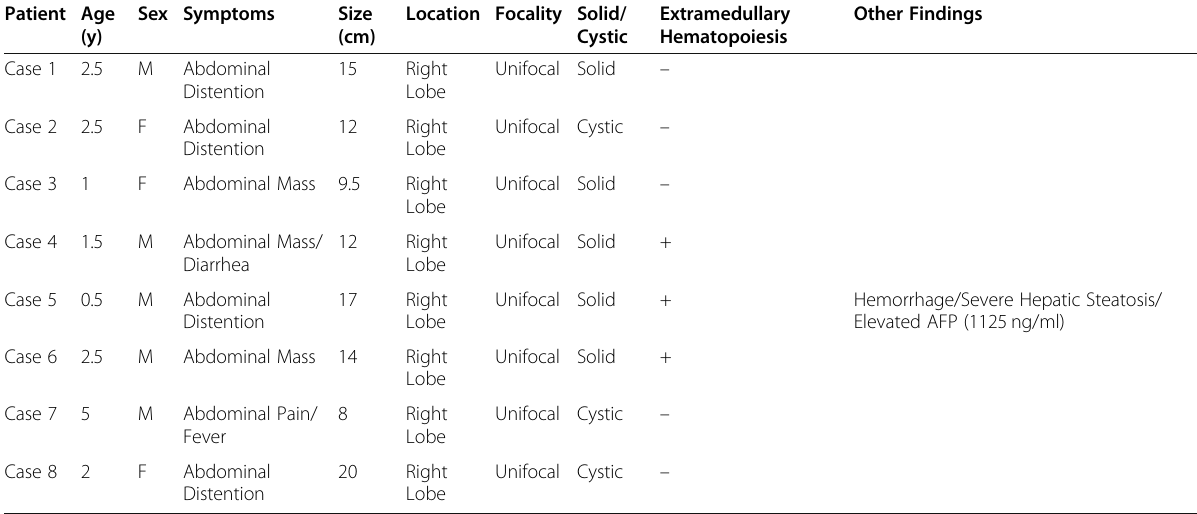
Table 2 Clinicopathologic characteristics and demographic features of patients with HMH